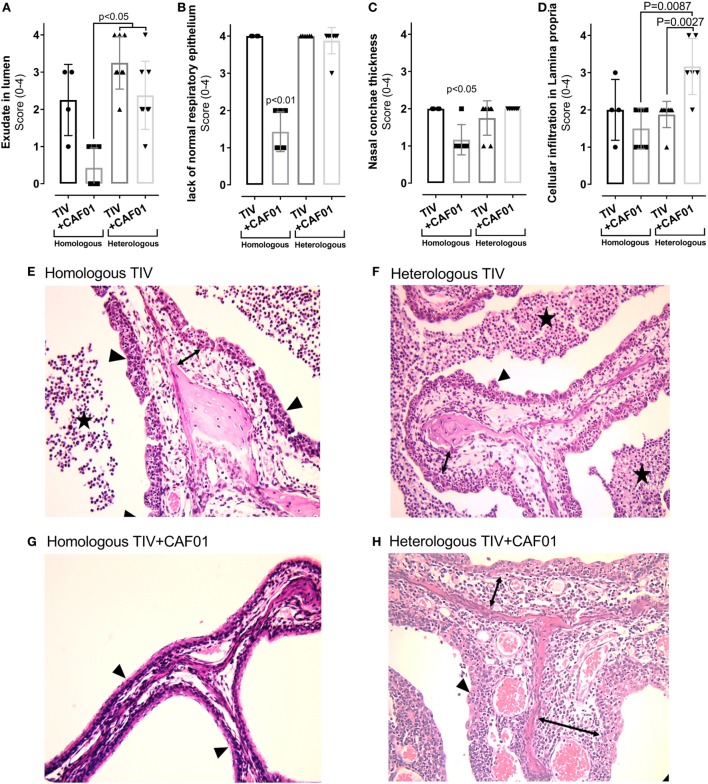
Histopathology in the nasal cavities of ferrets immunized two times with either homologous or heterologous trivalent influenza split-virion (TIV) vaccine with or without CAF01 adjuvant and euthanized 4 days after challenge with A/Brisbane/59/2007. (A–D) Scores of % of hematoxylin and eosin (H&E) stained sections lacking normal ciliated respiratory epithelium (A), exudate in lumen of the nasal cavity (B), ventral nasal concha thickness (C), and degree of inflammatory cell infiltration in lamina propria (D). Dots represent individual values and lines median values, n = 4 (homologous TIV), 6 (homologous TIV + CAF01), and 8 (heterologous TIV ± CAF01). Histological lesions observed in ferrets vaccinated with homologous TIV + CAF01 was clearly less severe compared to ferrets vaccinated with homologous TIV and heterologous TIV ± CAF01. Overall histological lesions observed in ferrets vaccinated with homologous TIV and heterologous TIV ± CAF01 were comparable; however, the degree of cellular infiltration in lamina propria was statistically significant higher in heterologous TIV + CAF01 compared to both heterologous TIV and homologous TIV + CAF01. (E–H) H&E-stained histological sections of nasal cavities showing unaffected thin nasal concha covered by normal ciliated respiratory epithelium from ferret vaccinated with homologous TIV + CAF01 (G) and clearly affected nasal cavities from ferrets vaccinated with homologous TIV (E), heterologous TIV (F), and heterologous TIV + CAF01 (H) with exudate in lumen, thickened nasal concha covered by hyperplastic epithelium lacking cilia, presence of transmigrating neutrophils and with a mixed inflammatory cell infiltration in lamina propria (most prominent in group TIV2009 + CAF01). Stars show exudate, arrowheads show epithelium, and lamina propria is marked with double-headed arrows. Bar = 500 μm. Non-parametric one-way ANOVA based on the data shown in each graph. Kruskal–Wallis test by ranks were used to compare the groups. Statistical significant difference is shown by p-value.